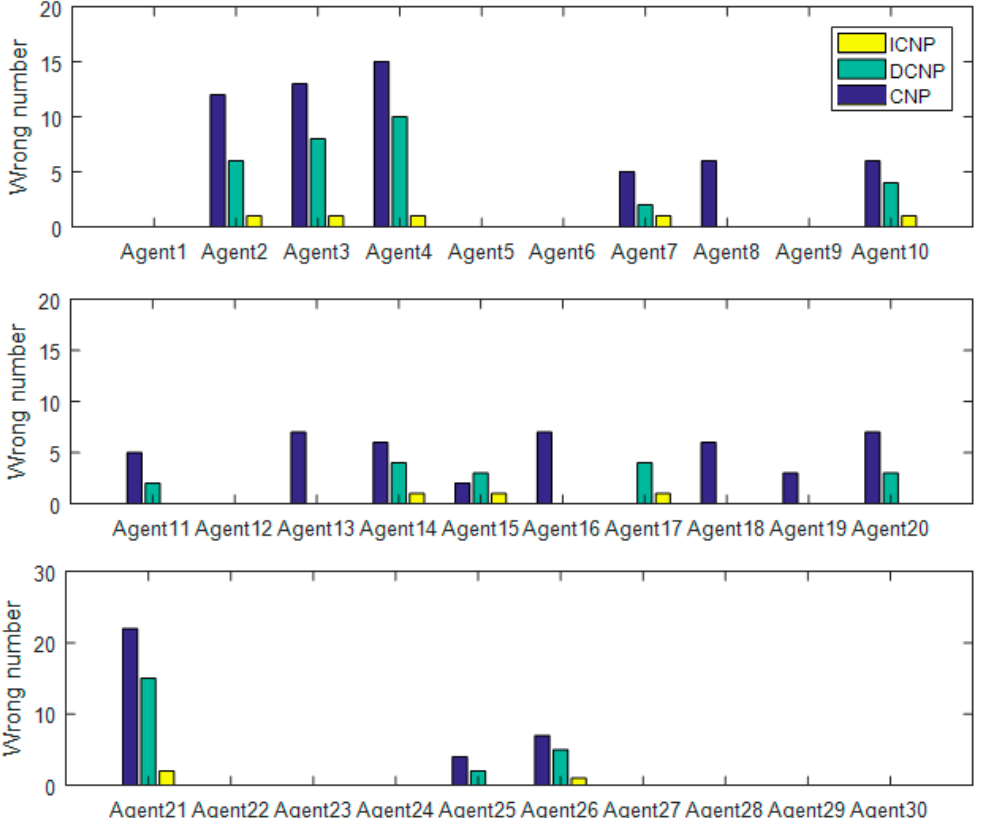
Figure 7. Task allocation of 30 agents under three algorithms.